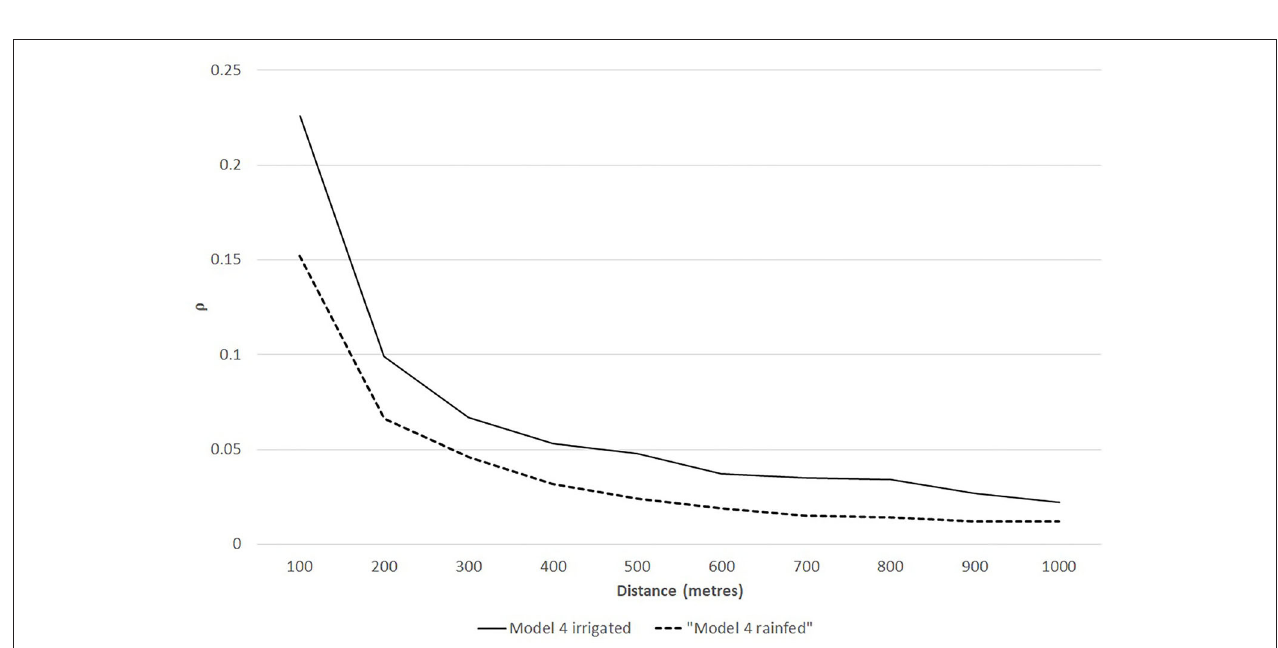
FIGURE 4 | Spatial dependence in the output (ρ) at different cut-off distances for model 4 in irrigated farms and rainfed farms.